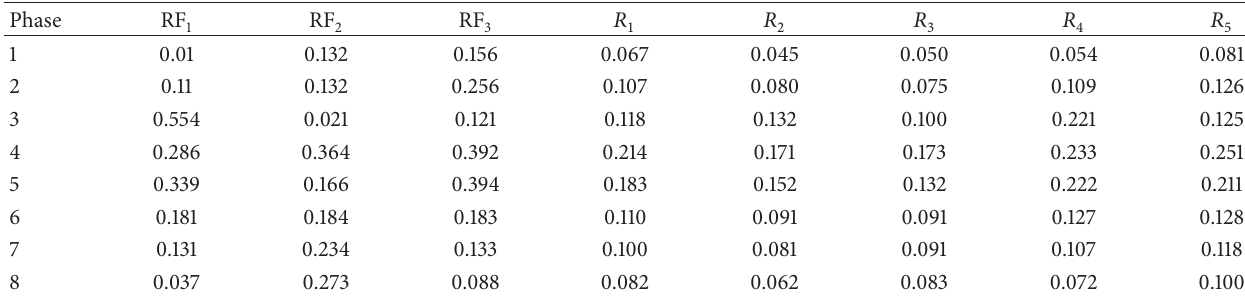
Table 1: Real likelihood of risk factor and risk in each phase.